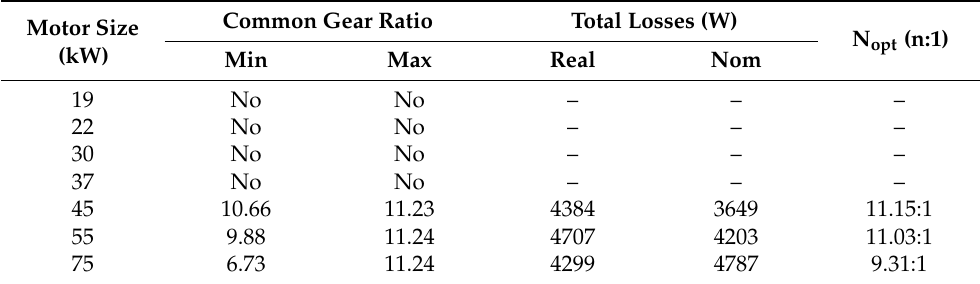
Figure 12. Selection of a common range of gear ratios: ( a ) common range is empty, ( b ) common range is 10.56–11.23. Table 6. Common affordable gear ratio for AC motors.